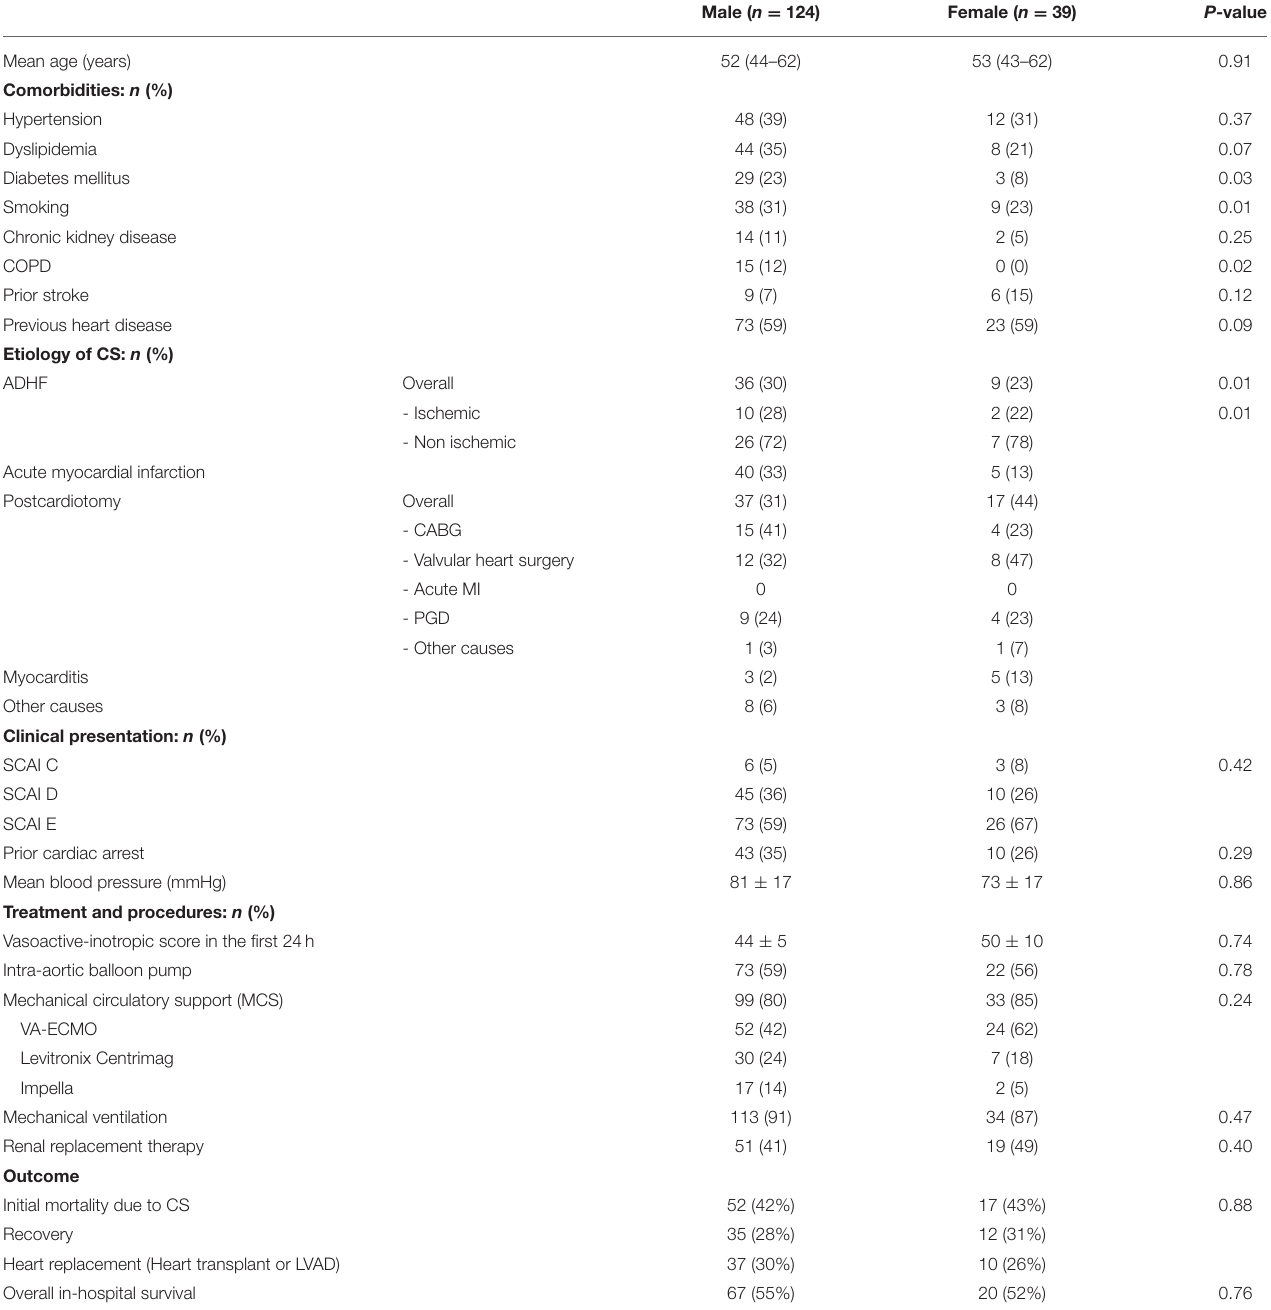
TABLE 1 | Baseline characteristics, treatment, and outcomes according to